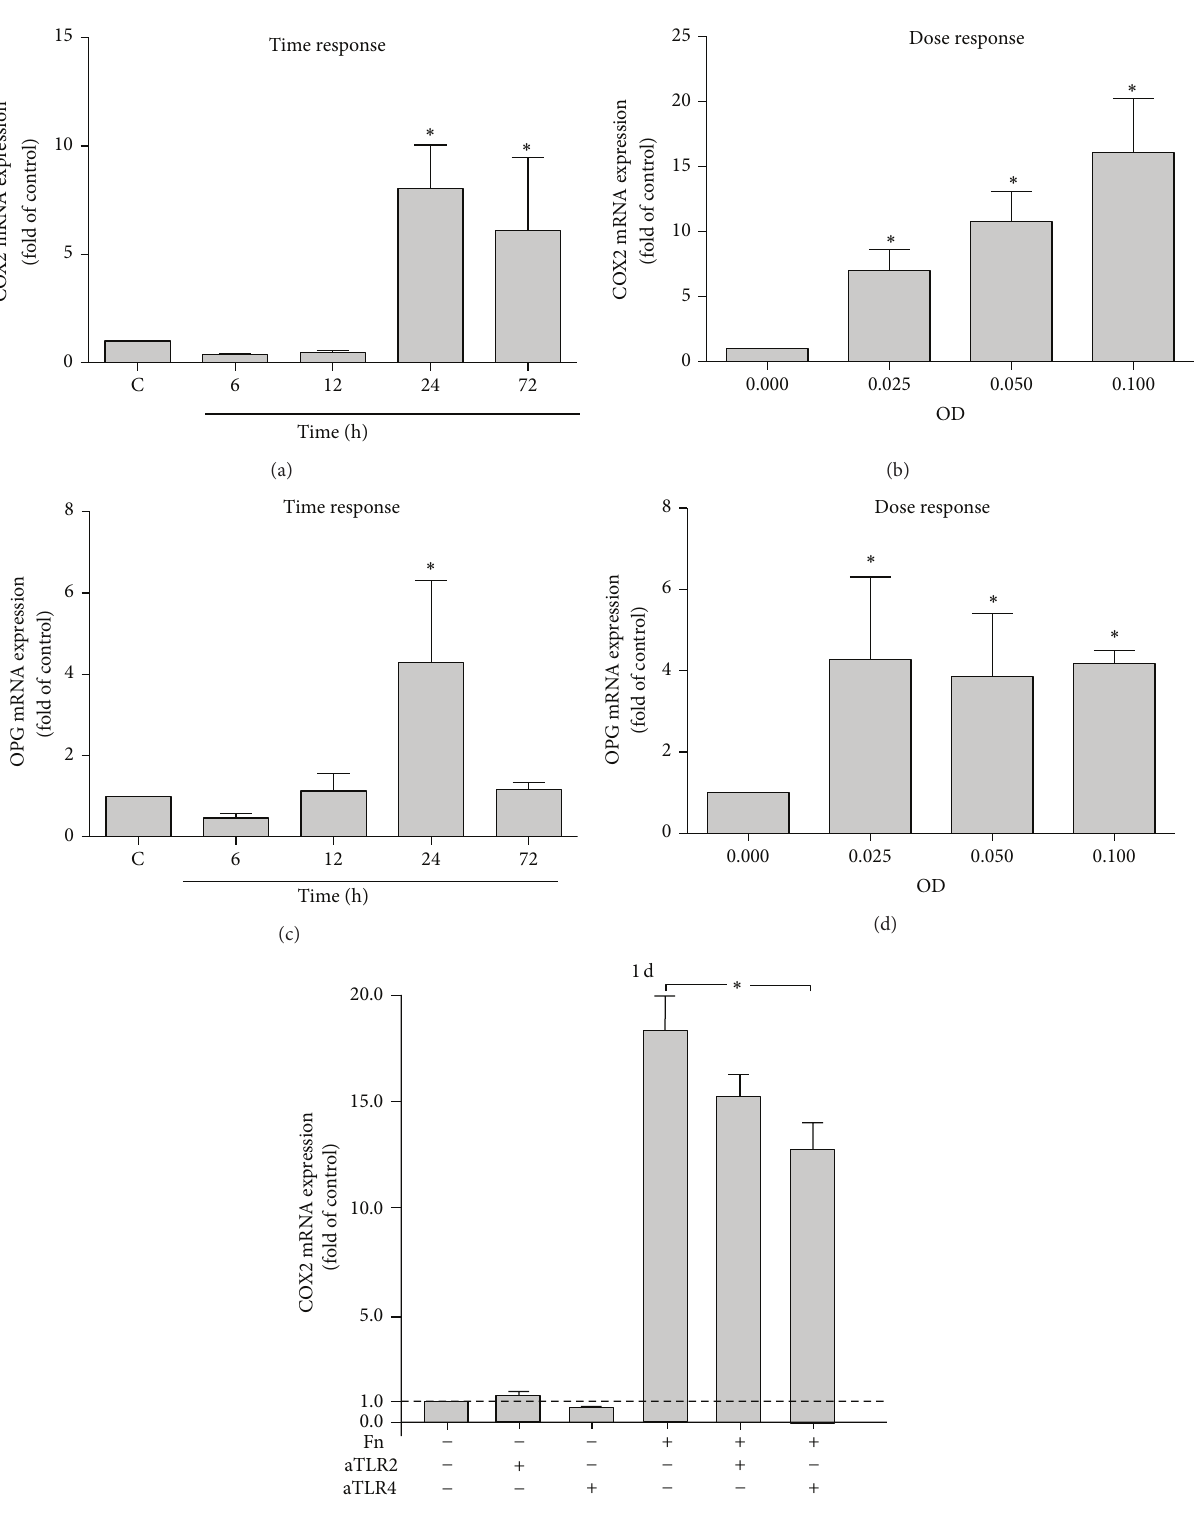
Figure 1: (a) COX2 expression in PDL cells stimulated by F. nucleatum ATCC 25586 over time. (b) COX2 expression in PDL cells stimulated by various concentrations of F. nucleatum ATCC 25586 at 1 day. (c) OPG expression in PDL cells stimulated by F. nucleatum ATCC 25586 over time. (d) OPG expression in PDL cells stimulated by various concentrations of F. nucleatum ATCC 25586 at 1 day. (e) COX2 expression in PDL cells stimulated by F. nucleatum ATCC 25586 (OD 0.025) in the presence or in the absence of anti-TLR2 or anti-TLR4 antibodies at 1 day. ∗ Significant difference between groups ( 𝑃 < 0.05